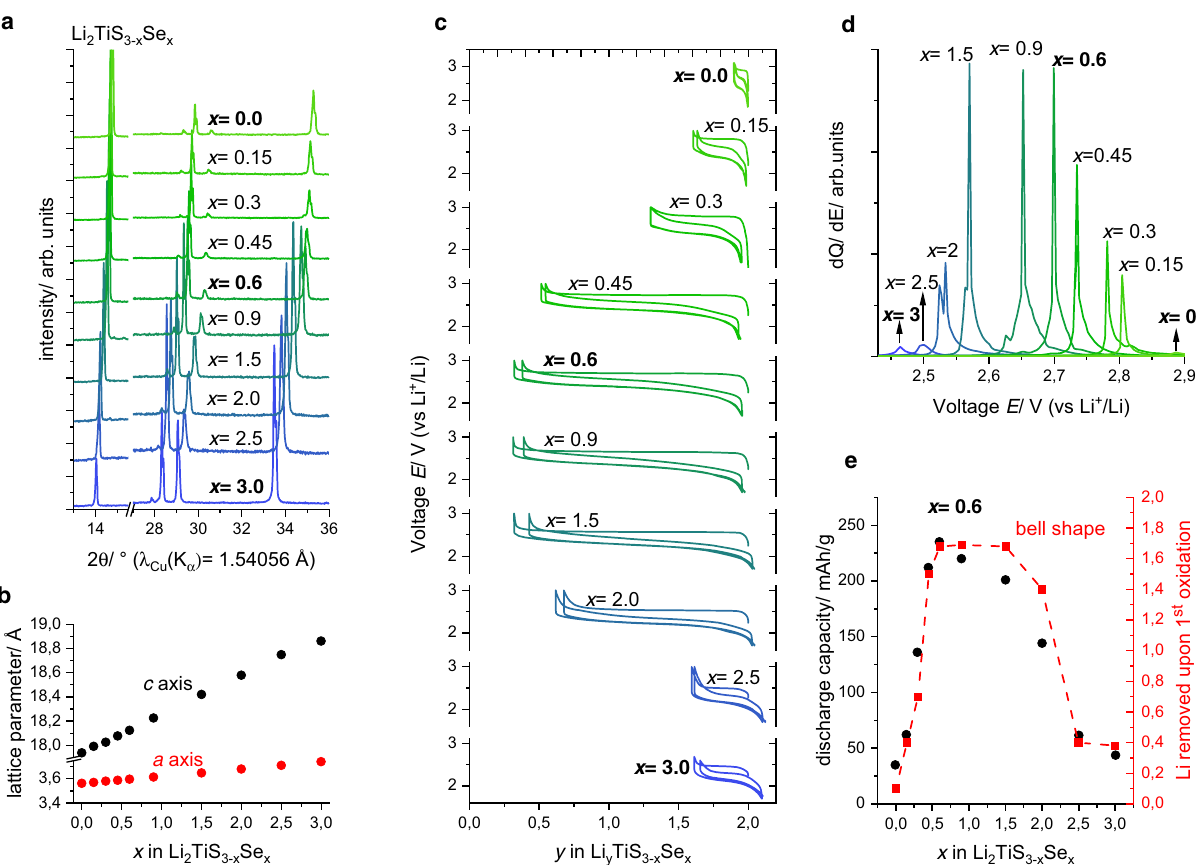
Fig. 1 Structural and electrochemical characterization of Li 2 TiS 3 − x Se x . a PXRD patterns of synthesized materials in Li 2 TiS 3 − x Se x : a shift towards lower 2 θ angles (higher d -spacing) is observed upon Se introduction. b Lattice parameters re fi ned in R (cid:1) 3 m plotted against the Se content x in Li 2 TiS 3 − x Se x . c Voltage traces of the fi rst two galvanostatic cycles. d Change of the differential capacity d Q /d E of the fi rst oxidation process with Se doping. The lowering of the activation potential indicates successful manipulation of the anionic band. The decreased voltage is consistent with increased covalency of Ti – Se bonds compared to Ti – S bonds and with the lower chemical hardness of Se compared to S. e Gravimetric discharge capacity of the fi rst discharge process (black) and the electrochemical activity (amount of removable Li upon the fi rst oxidation)